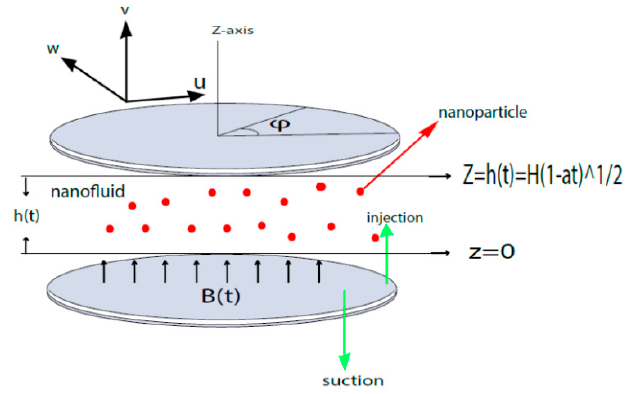
Figure 1. Geometry of the problem.